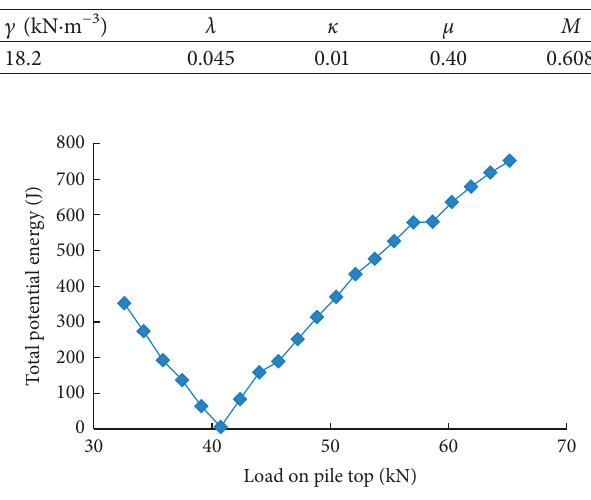
Figure 8: Energy with load on pile top. Table 4: Comparison between calculated and measured stress ratio.